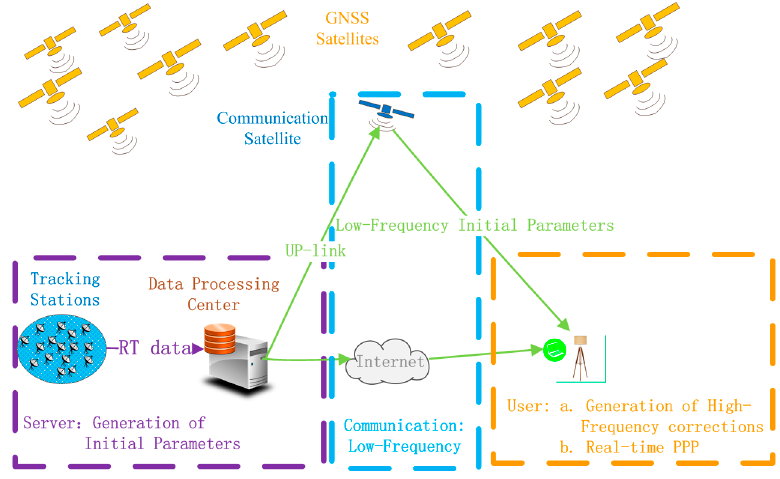
Figure 1. System architecture of the new real-time PPP system.